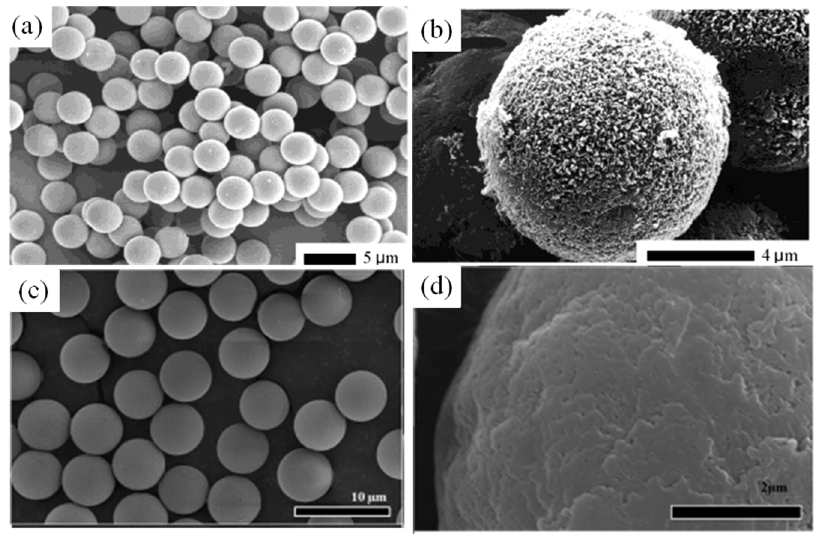
Figure 5. SEM images of ( a ) PMMA and ( b ) PMMA/PANI particles synthesized by Cho M.S. et al. [57] (Copyright American Chemical Society, 2003) and ( c ) PMMA and ( d ) PMMA/PANI particles synthesized by Fang et al. [122] (Copyright The Royal Society of Chemistry, 2011), respectively.